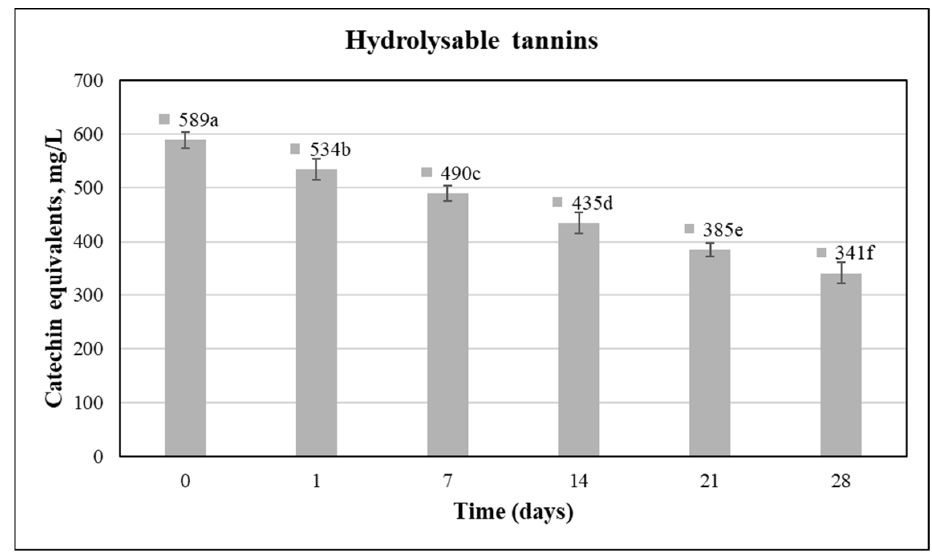
Figure 3. Hydrolysable tannins of fermented pomegranate beverages; similar superscript letters in bars denote no significant differences at an alpha = 0.05 (ANOVA and Duncan Post Hoc Multiple Comparisons).